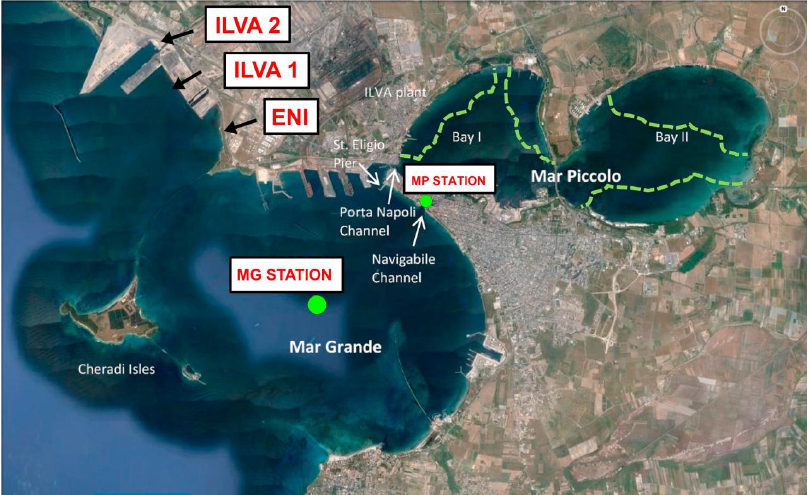
Figure 1. Target area: location of the industrial discharges and monitoring station.